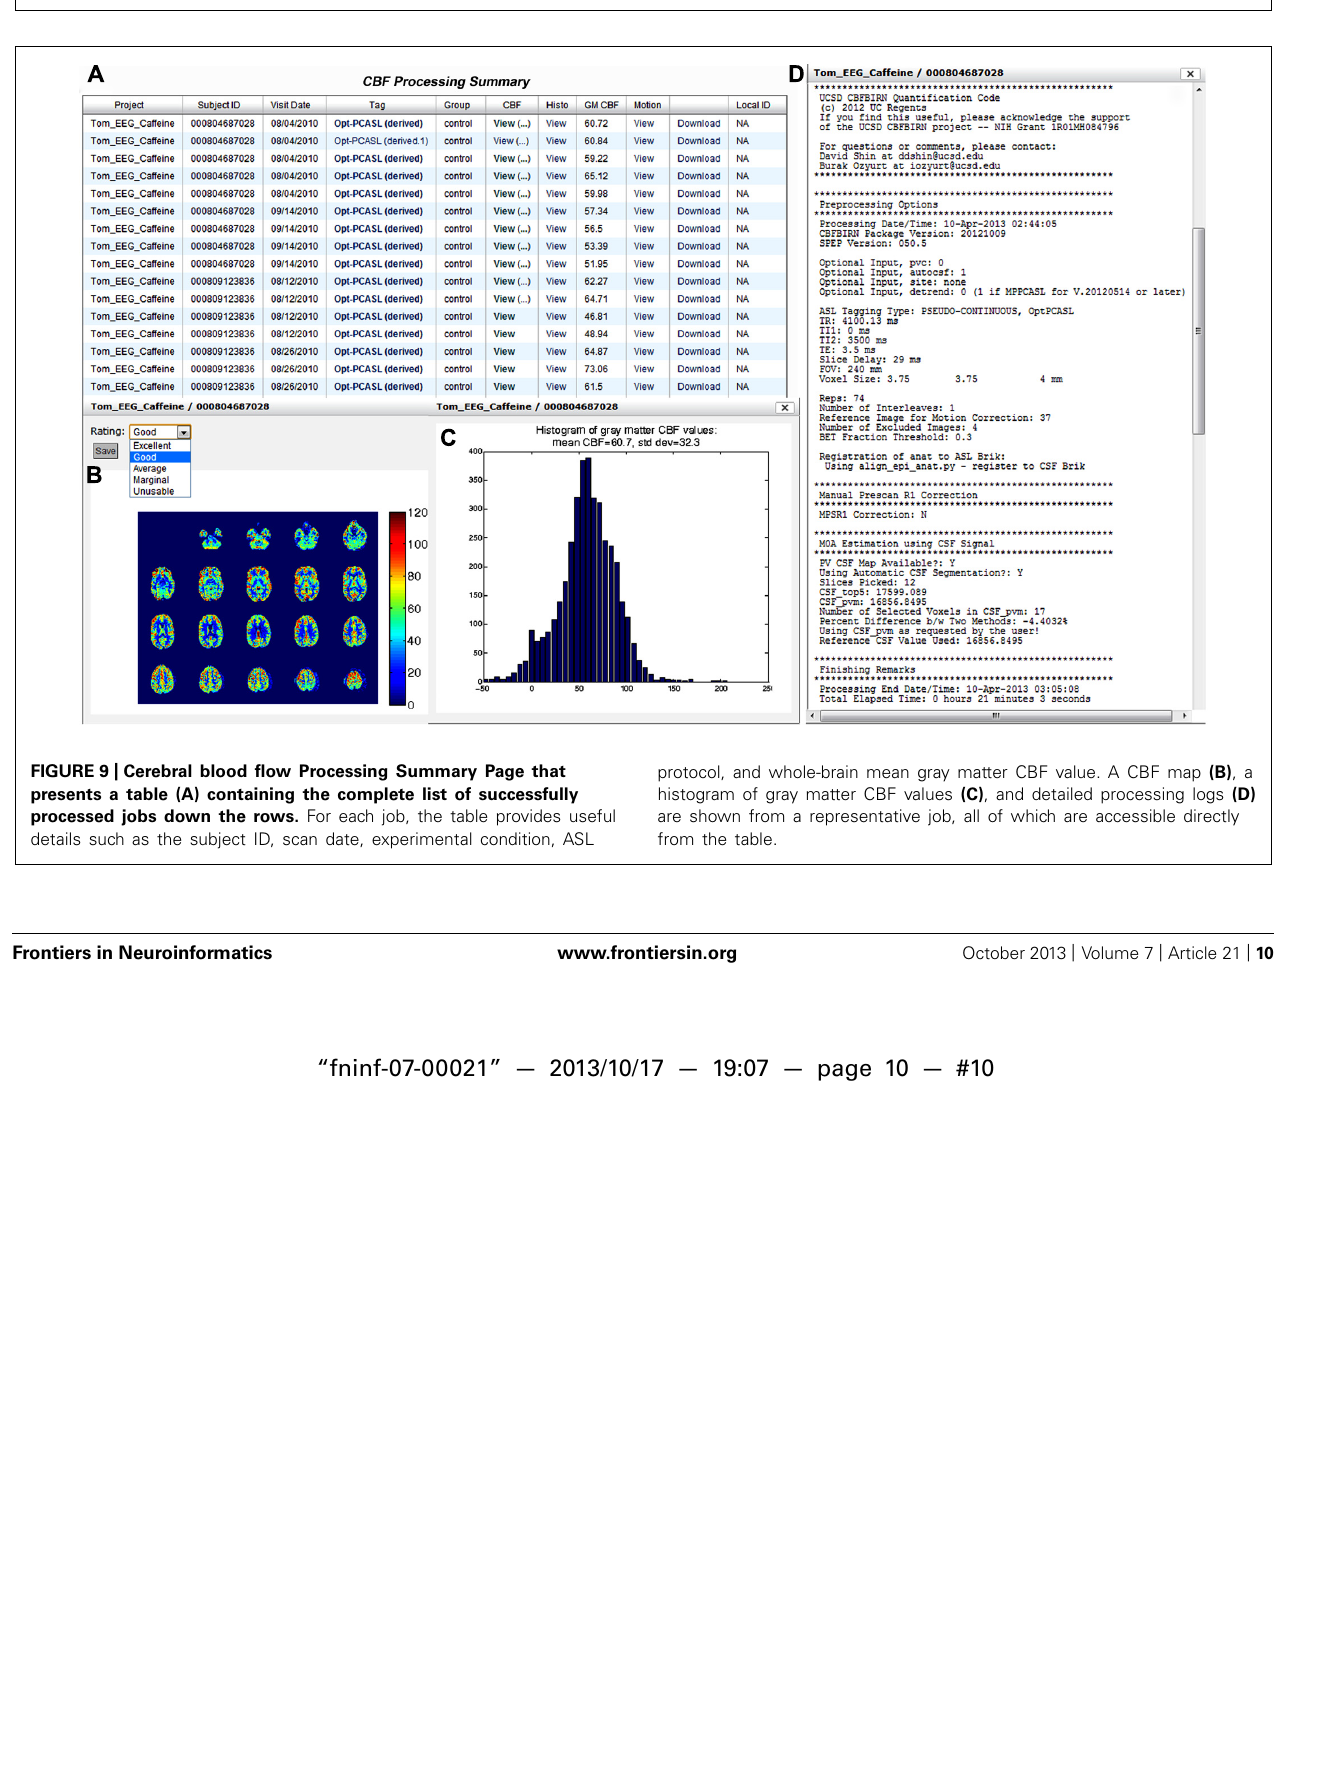
FIGURE 8 | Cerebral blood flow GroupAnalysis Job – Factor Selection page from an example group analysis job. Nine factors and corresponding factor levels are shown based on the user-selected CBF maps, in which two factors are selected, i.e., Diagnosis and Gender.